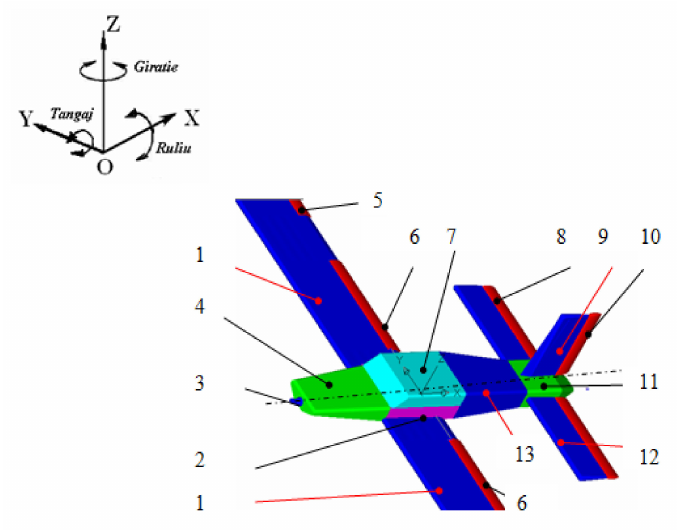
Figure 1. A new light aircraft. 1—the median wing of rectangular shape and having in part an asymmetrical profile so that the chord of the profile forms an angle of incidence with the direction of advance and an angle of choke of a certain length L , 2—the central plane of the fuselage, 3—the helmet of the propeller, 4—front fuselage (bonnets), 5—aileron, 6—curved flaps or single flaps (one on each wing) located on the trailing edge without hinges (without axes of rotation on the wings), 7—the cab, 8—the depth (the moving part of the horizontal tail), 9—the drift (the fixed part of the vertical tail), 10—the direction (the moving part of the vertical plumage), 11—rear fuselage, 12—stabilizer (fixed part of the horizontal tail), 13—central fuselage (2nd